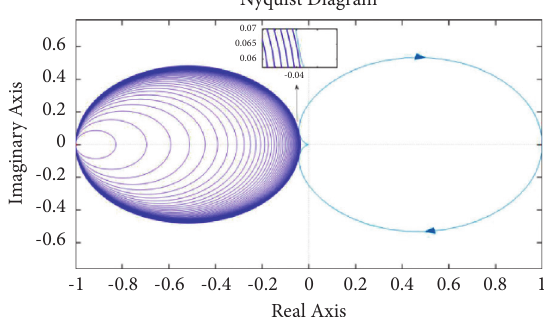
with the selected ω out of the stable range. 1 1 s